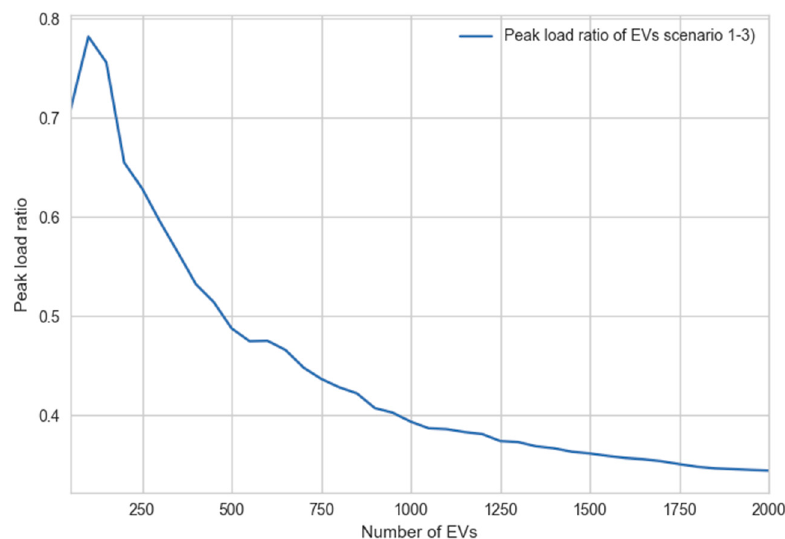
Figure 17. The ratio between the maximum peak of the EVs charging Scenario 4 and the peak of the EVs charging in Scenarios 1–3. This indicates potential savings on the costs for the c harging p oint o perator /m obility s ervice p rovider (CPO/MSP) of their maximum peak